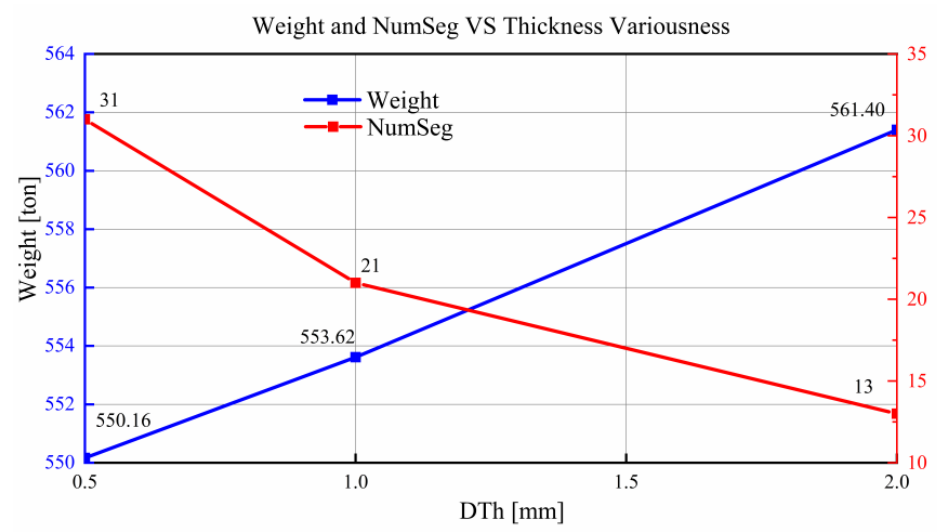
Figure 11. Weight and number of segments of different thickness VS. thickness variousness.